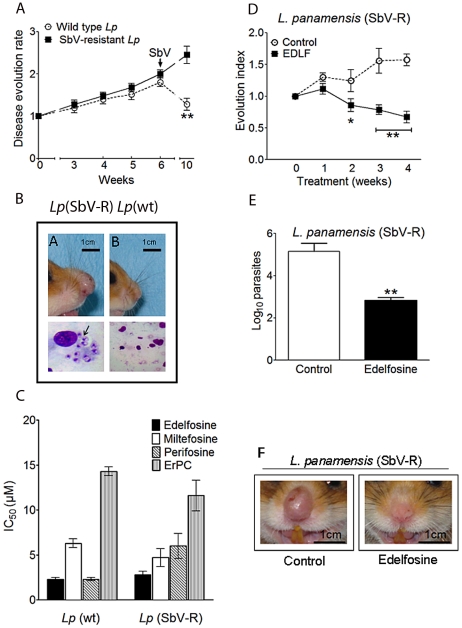
Sensitivity of SbV-resistant L. panamensis parasites to edelfosine.(A) Two groups of eight golden hamsters each were infected in the nose with wild type and SbV-resistant L. panamensis (Lp) promastigotes, and after the sixth week post-infection, they were treated with a daily intramuscular injection of Glucantime (SbV) for 4 weeks. Disease evolution rate was measured along the whole process through determining nose thickness as compared to figures obtained before infection. (B) Golden hamsters inoculated with SbV-resistant (SbV-R) L. panamensis (Lp) did not respond to treatment with Glucantime (inflamed nose) (upper left panel), and nose smears showed amastigotes within macrophages (arrow) following Giemsa staining (lower left panel). However, hamsters infected with wild type (wt) L. panamensis (Lp) fully responded to Glucantime treatment, showing uninflamed nose and negative staining for amastigotes in nose smears (upper and lower right panels). (C) IC50 values of edelfosine, miltefosine, perifosine, and erucylphosphocholine (ErPC) for in vitro growth inhibition of wild type (wt) and SbV-resistant (SbV-R) L. panamensis (Lp) promastigotes were determined by XTT assays. (D–F) Golden hamsters were infected with 1×106 SbV-resistant L. panamensis promastigotes in the nose, and after nose inflammation was evident, hamsters were randomized into drug-treated (26 mg edelfosine/kg of body weight, daily oral administration for 28 days) and control (water vehicle) groups of 7 hamsters each. (D) Lesion development was monitored by measuring nose thickness at regular intervals and comparison to values obtained before treatment (evolution index). (E) Parasite load was determined by limiting dilution assays after completion of the 4-week in vivo assay. (F) Edelfosine treatment led to a dramatic decrease and amelioration in parasite-induced nose thickness and damage, as shown by photographs from drug-free control and edelfosine-treated hamsters. Data are means ± SD or representative experiments (n = 7). Asterisks indicate that differences between control and edelfosine-treated groups, or between wild type and SbV-resistant parasites treated with SbV, are statistically significant. (*) P<0.05. (**) P<0.01.